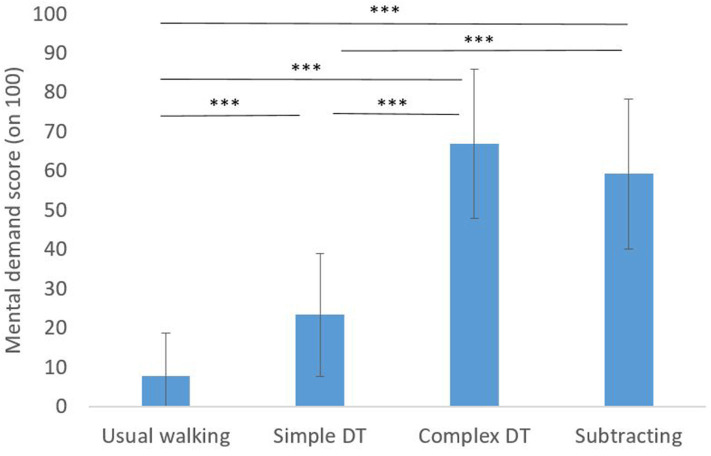
Mean values of the mental demand subitem of the NASA-TLX questionnaire. Significance level between conditions: ***p < 0.001 Error bars represent ±1 SD.